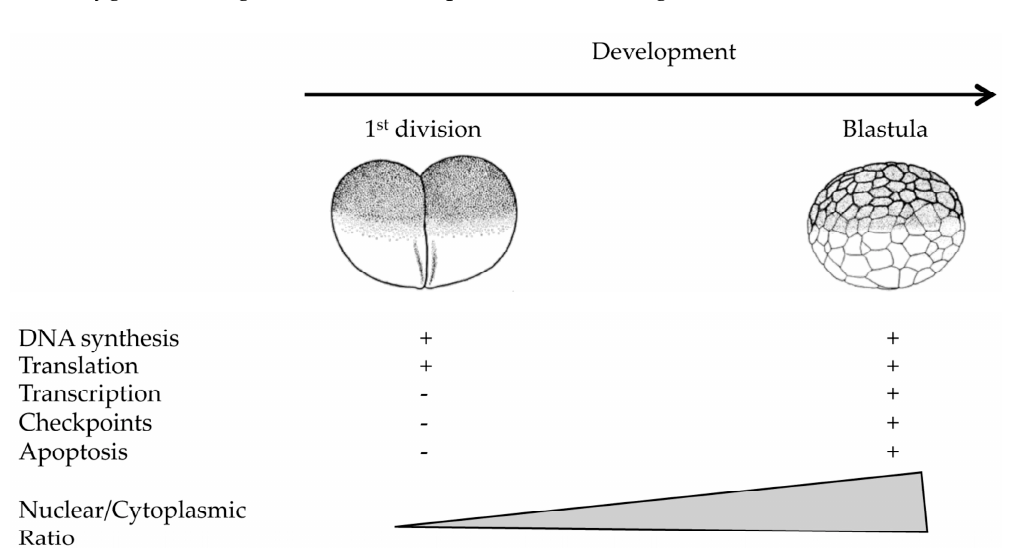
Figure 1. Reactivation of cellular processes during the early development of Xenopus laevis . Apart from DNA synthesis and translation, several cellular processes are inactive during the early stages of development. These processes are restored close to the time when zygotic transcription is activated, the midblastula transition in fast cleaving embryos such as Drosophila and Xenopus .